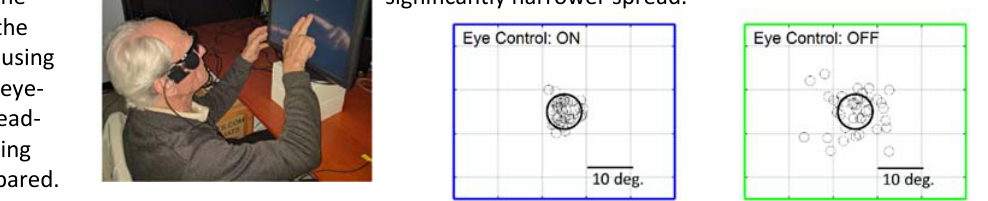
Figure 1. A white target appeared on a touch‐ screen monitor and the patients were instructed to report the location of the target by touching the monitor. The